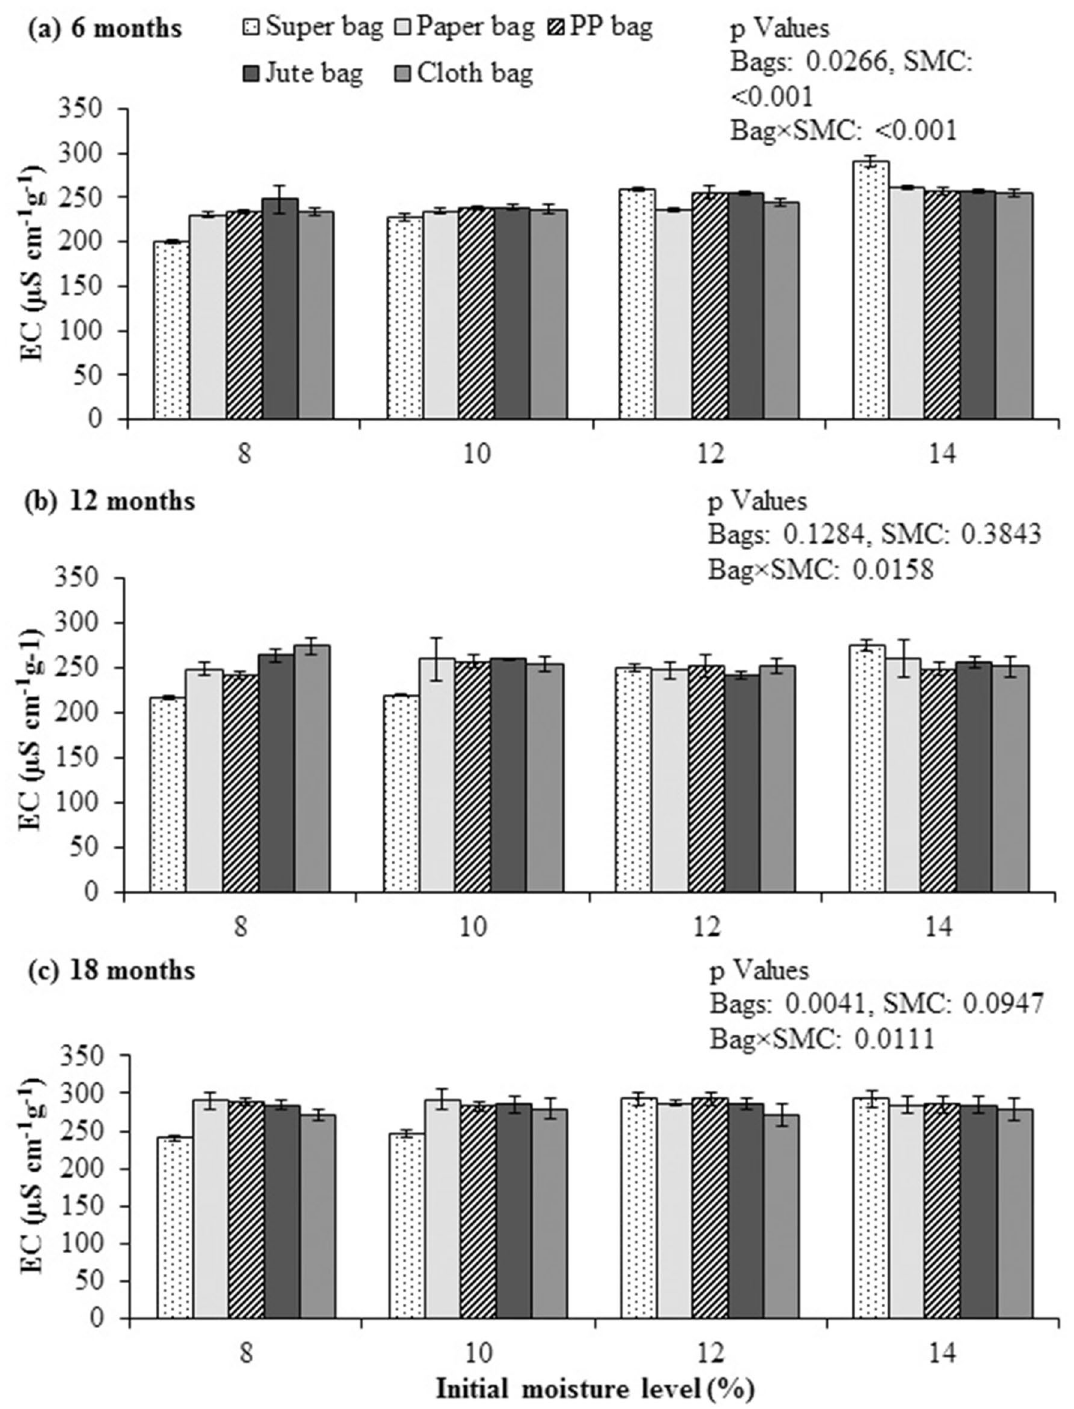
Figure 4. Electrical conductivity (EC) of quinoa seed after 6 ( a ), 12 ( b ) and 18 ( c ) months of storage at various seed moisture levels in different packaging